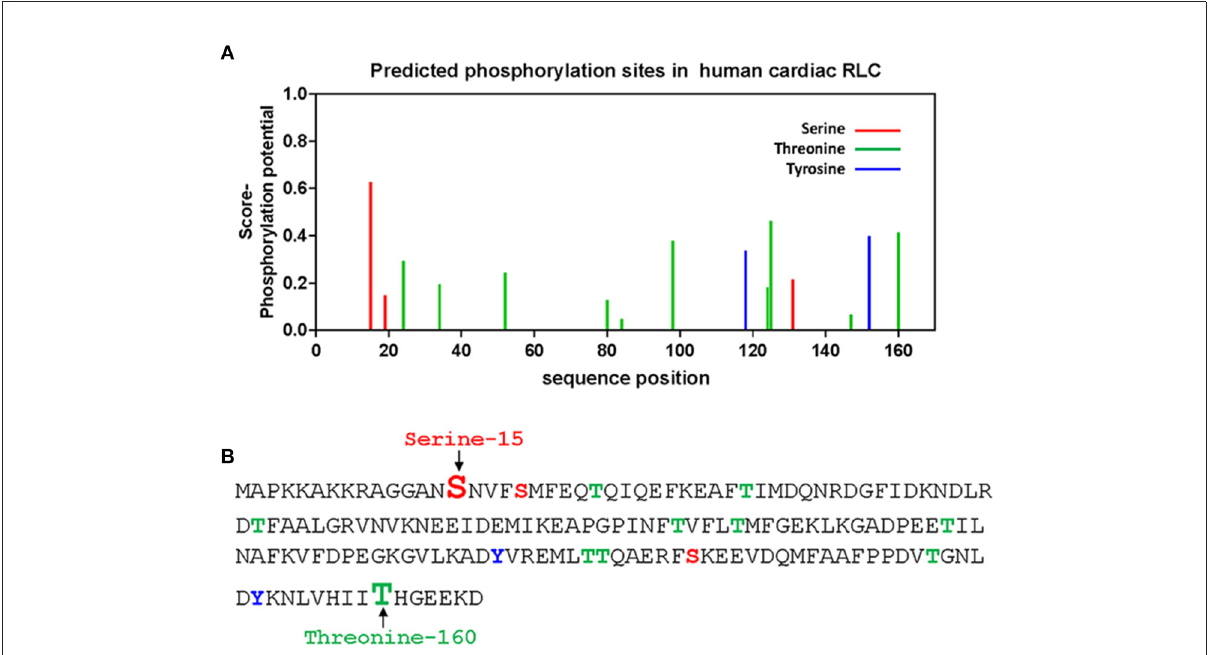
FIGURE1 In-silico prediction of phosphorylation sites of the human cardiac RLC. (A) Phosphorylation of Ser/Tyr/Thr sites in the RLC was predicted by PhosphoSVM search http://sysbio.unl.edu/PhosphoSVM/prediction.php/. (B) Amino acid sequence of the human cardiac RLC (NCBI_P10916) with the location of predicted pSer, pTyr, and pThr residues. Bolded and enlarged, the S15 (in red font) and T160 (in green font) sites are studied in this